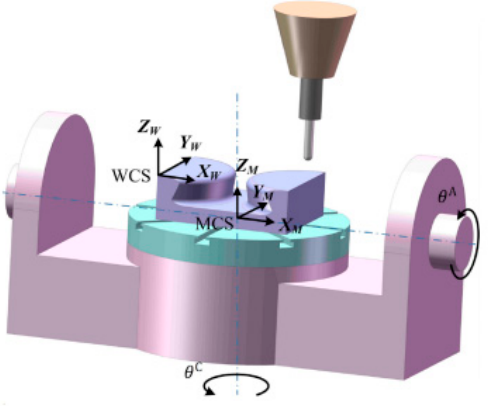
Figure 7. 5-axis tool with table tilt A-C and X, Y, and Z axis. Adapted from [78], 2021, Elsevier.